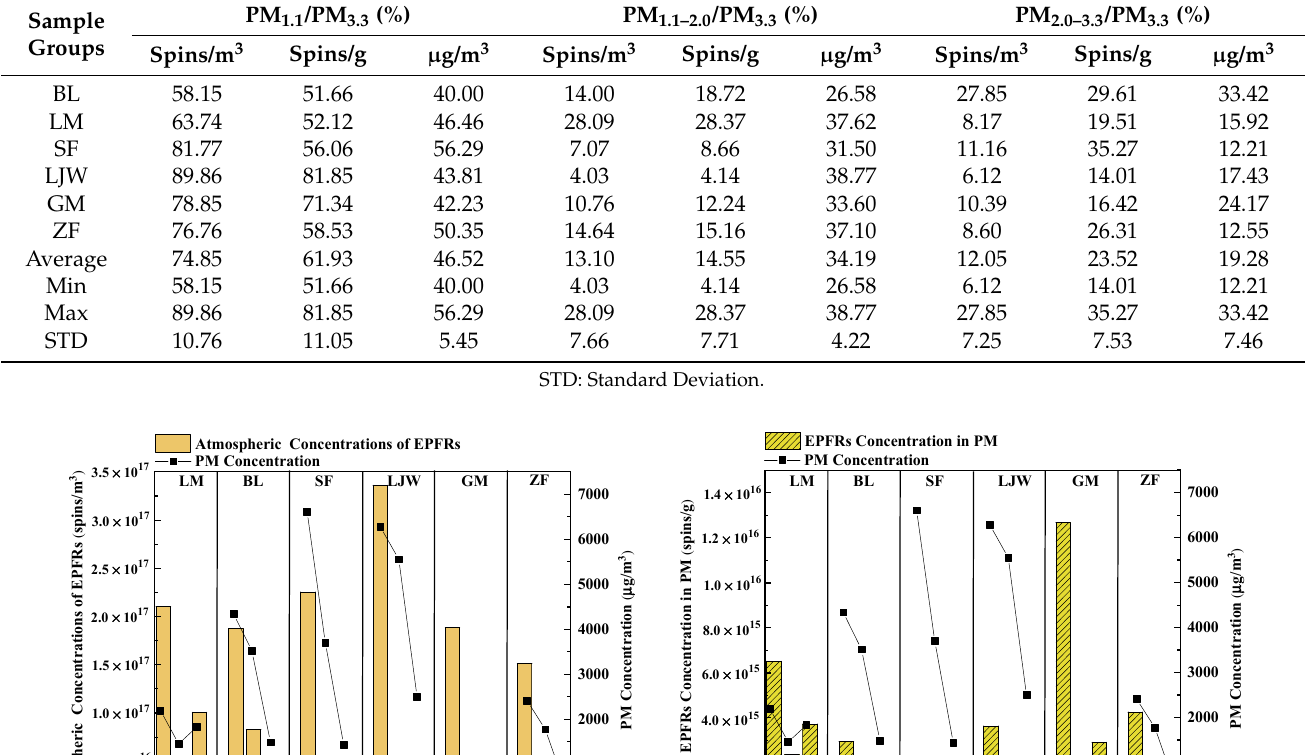
Table 3. Size distribution of EPFRs and PM in simulated coal combustion particles from Xuanwei (%). Sample Groups